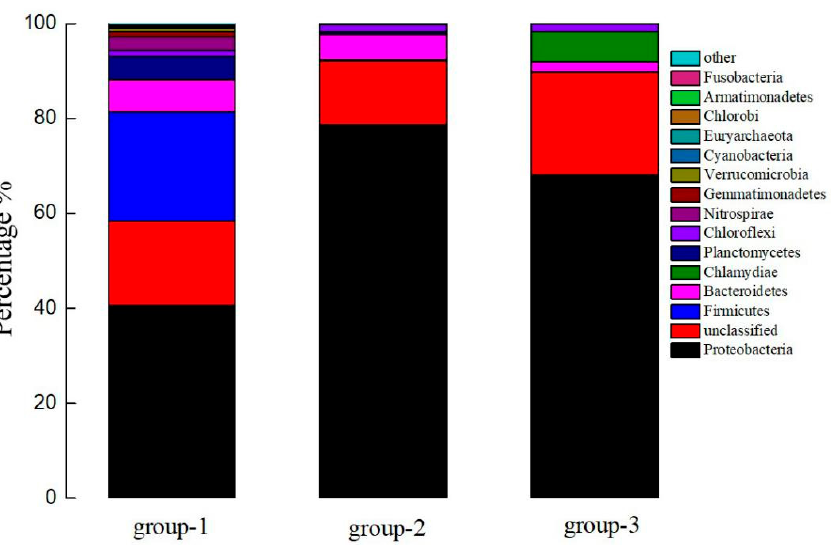
Figure 8. The relative percentages of the community constitution at the phylum level.